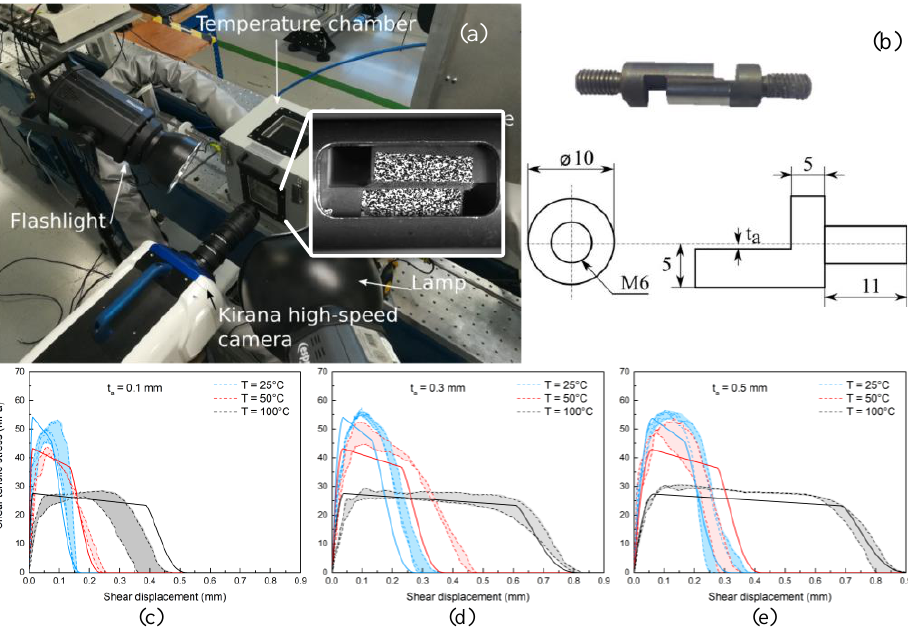
Figure 1. Experimental setup (a) and fixtures (b) employed to test the single lap shear joint specimens at different temperatures. Experimental vs. numerical high strain rate traction-separation curves of mode II specimens for thicknesses of 0.1 (c), 0.3 (d) and 0.5 mm (e) with varying